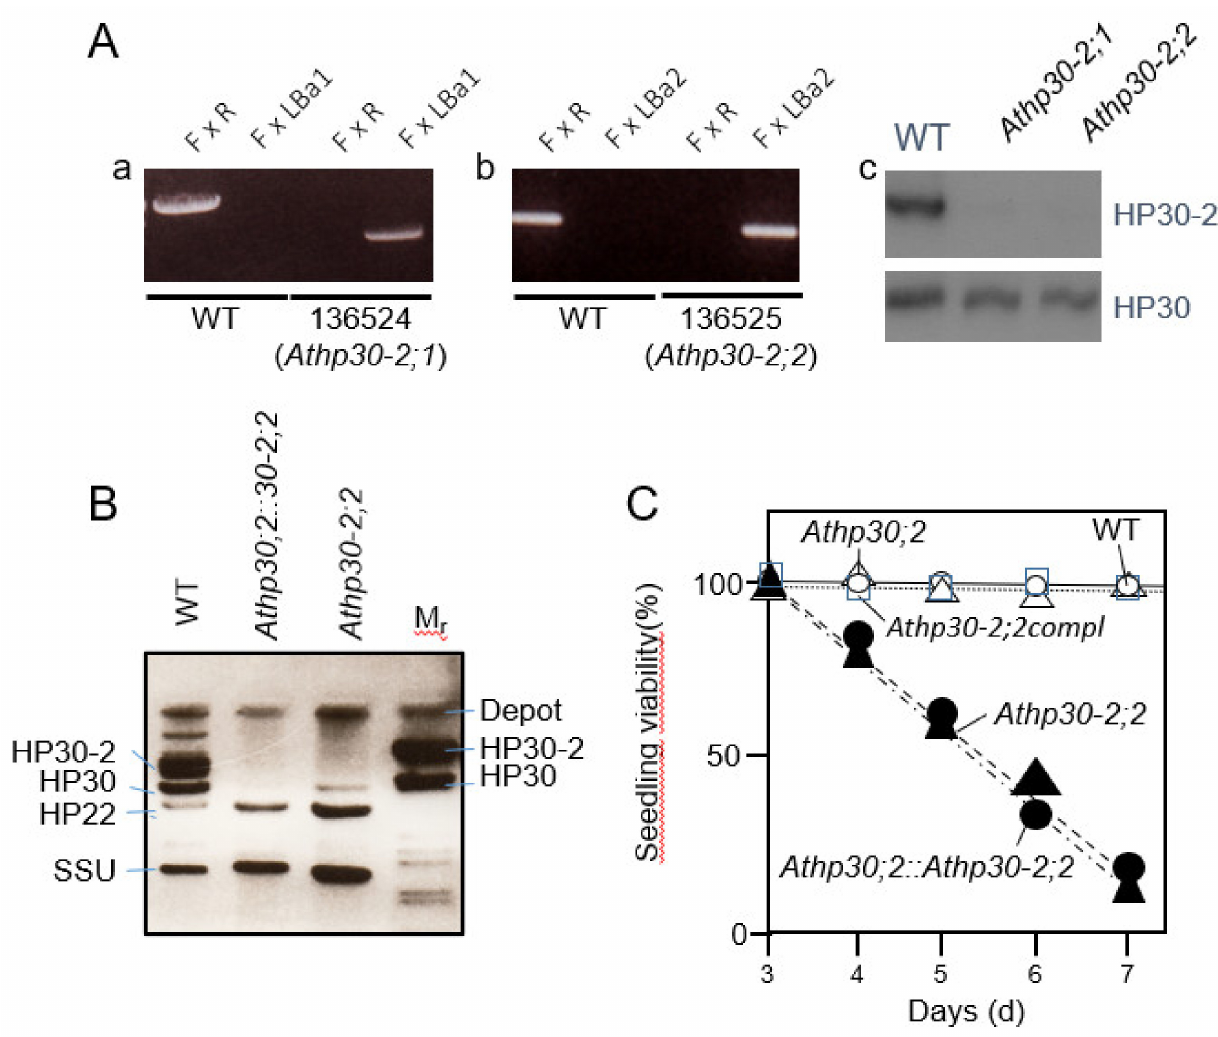
Figure 2. Characterization of Athp30-2;1 (SALK_ 136524) and Athp30-2;2 (SALK_ 136525) mutants. ( A ) Identification of Athp30-2;1 (SALK_136524) ( a ) and Athp30-2;2 (SALK_136525) ( b ) through genotyping using the indicated primer combinations and confirmation of the absence of HP30-2 protein in Athp30-2;1 and Athp30-2;2 versus wild-type (WT) plants through Western blotting using a mono-specific antibody ( c , upper panel). For reference, a replicate protein gel blot was probed with HP30 antibodies ( c , lower panel). ( B ) Absence of HP30-2 protein in Athp30-2;2 (SALK_136525) single and Athp30-2;2 (SALK_136525)::Athp30;2 (SALK_112126) double mutants versus wild-type (WT) plants. Shown is a Western blot of chloroplast proteins that was simultaneously probed with mono-specific antisera against HP22, HP30 and HP30-2 as well as the small subunit of ribulose-1,5-bisphosphate carboxylase/oxygenase (SSU). ( C ) Seedling viability of Athp30;2 (SALK_112126)(open triangles) and Athp30-2;2 (SALK_136525)(filled triangles) single mutants, and Athp30;2:: Athp30-2;2double mutant plants (dots), as compare to the wild-type (WT)(open circles) and Athp30-2;2 expressing the HP30-2 cDNA